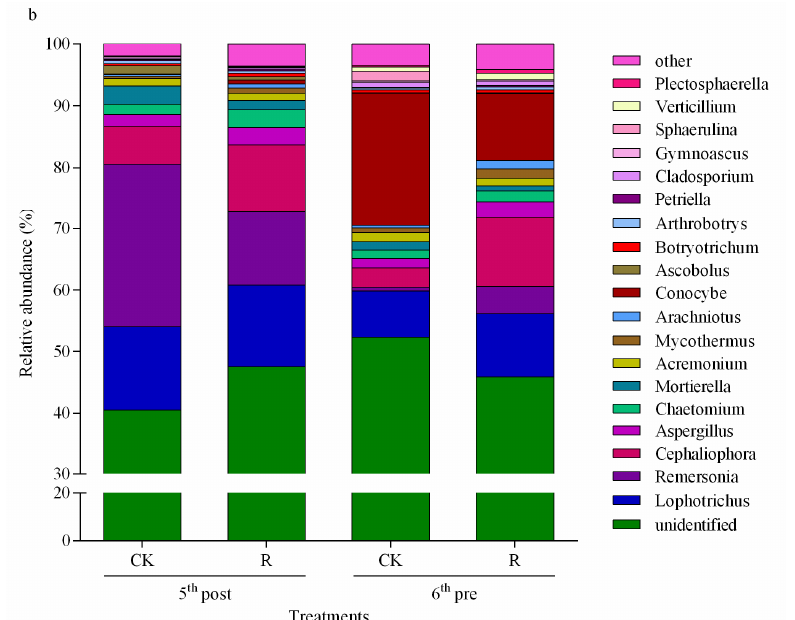
Figure 2. The microbial communities and the relative abundances of microbial genera (( a ) for bacteria, ( b ) for fungi). CK, the non-vegetable residue treatment; R, the vegetable residue treatment; pre, the pre-returning stage; post, the post-returning stage; number 5 and 6, the times of in situ vegetable residue return.